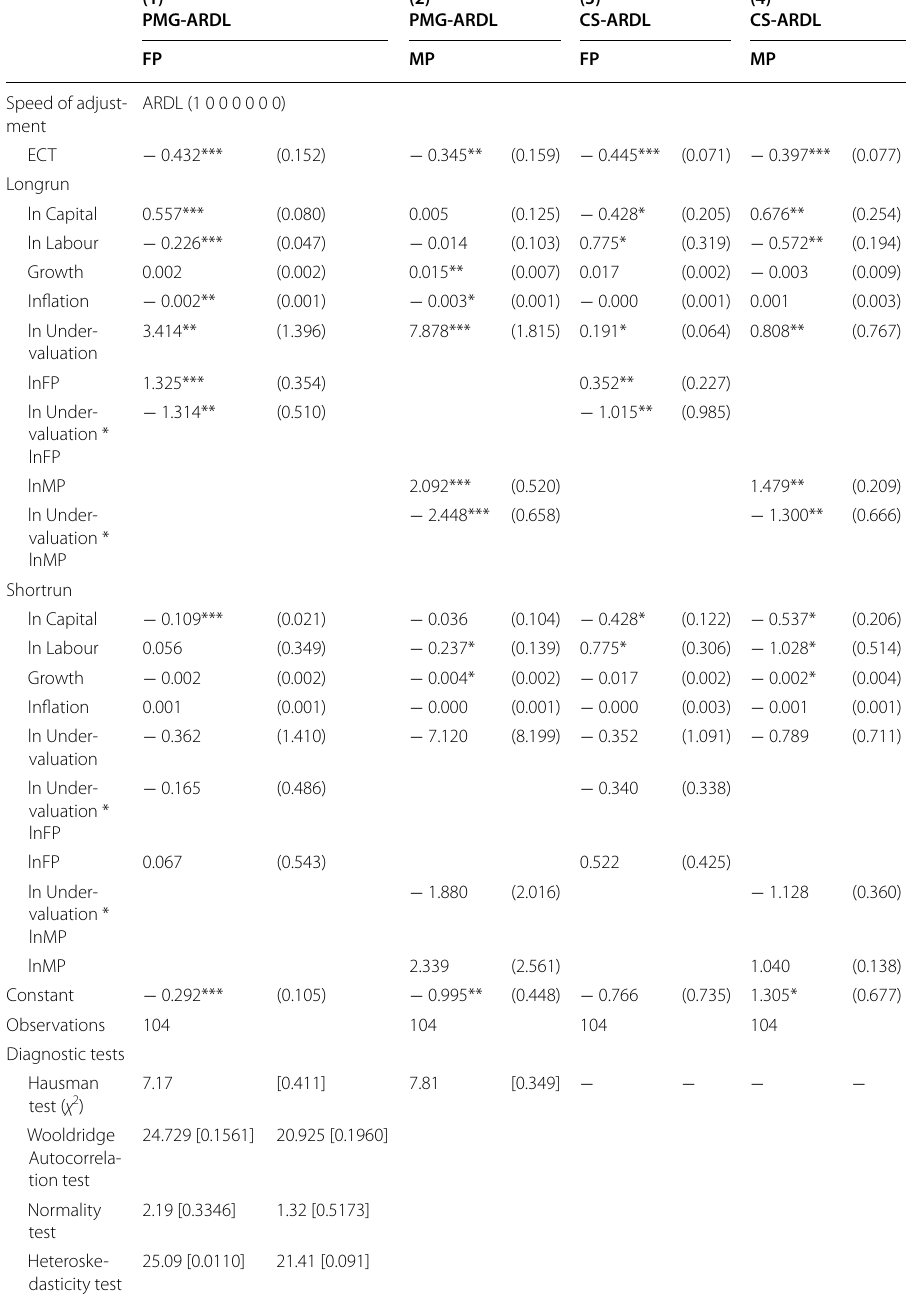
Table 7 Fiscal and Monetary policy interaction effects on the service sector performance. Source: Authors’